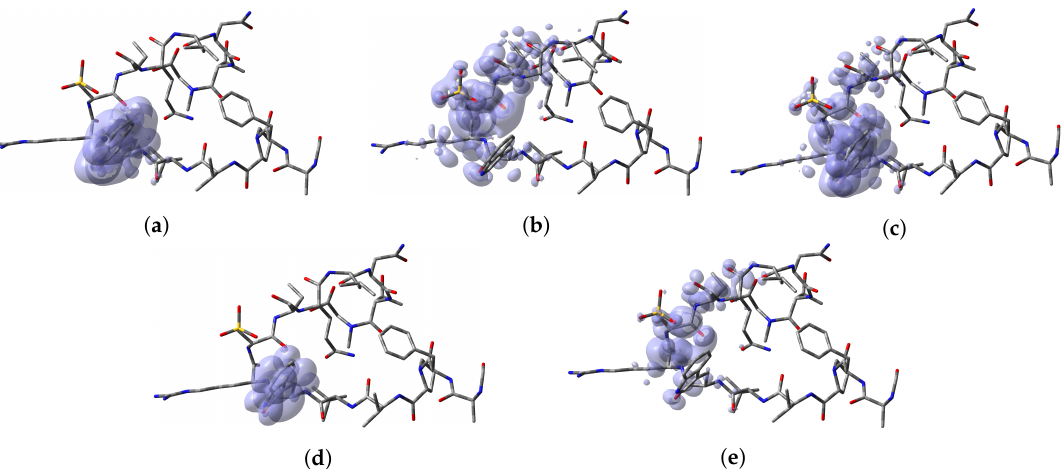
Figure A2. Graphical sketches of the local reactivity descriptors for Discodermin B showing the reactivity regions: ( a ) Electrophilic Fukui Function f − , ( b ) Nucleophilic Fukui Function f + , ( c ) Radical Fukui Function f 0 , ( d ) Electrophilic Parr Function P − and ( e ) Nucleophilic Parr Function P + . Table A3. Condensed local reactivity descriptors for Discodermin C denoting the reactivity sites: Electrophilic Fukui Function f − , Nucleophilic Fukui Function f + , Radical Fukui Function f 0 , Electrophilic Parr Function P − and Nucleophilic Parr Function P + .